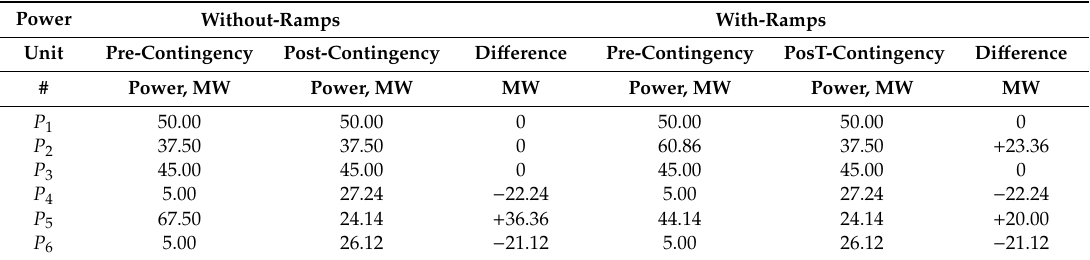
Table 2. Power generation solution for pre- and post-contingency